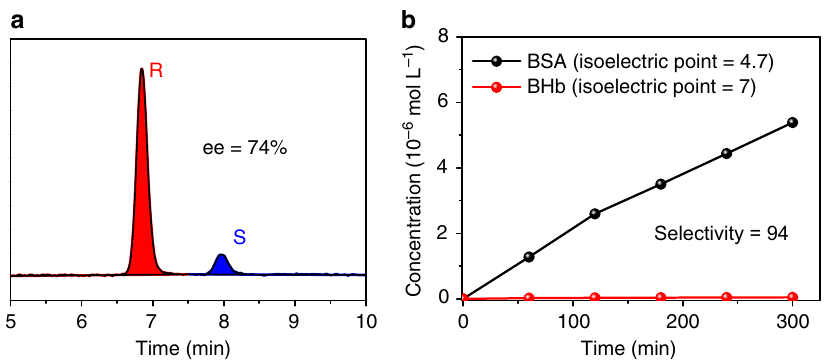
Fig. 4 MOF PE MMM adsorbers for chiral resolution and proteins separation. a High-performance liquid chromatogram of chiral MPS permeate after fi ltration by Zn-BLD PE MMM-86%. b Proteins (BSA and BHb) concentration pro fi les in the permeate fi ltrated by MIL-100(Cr) PE MMM-86%